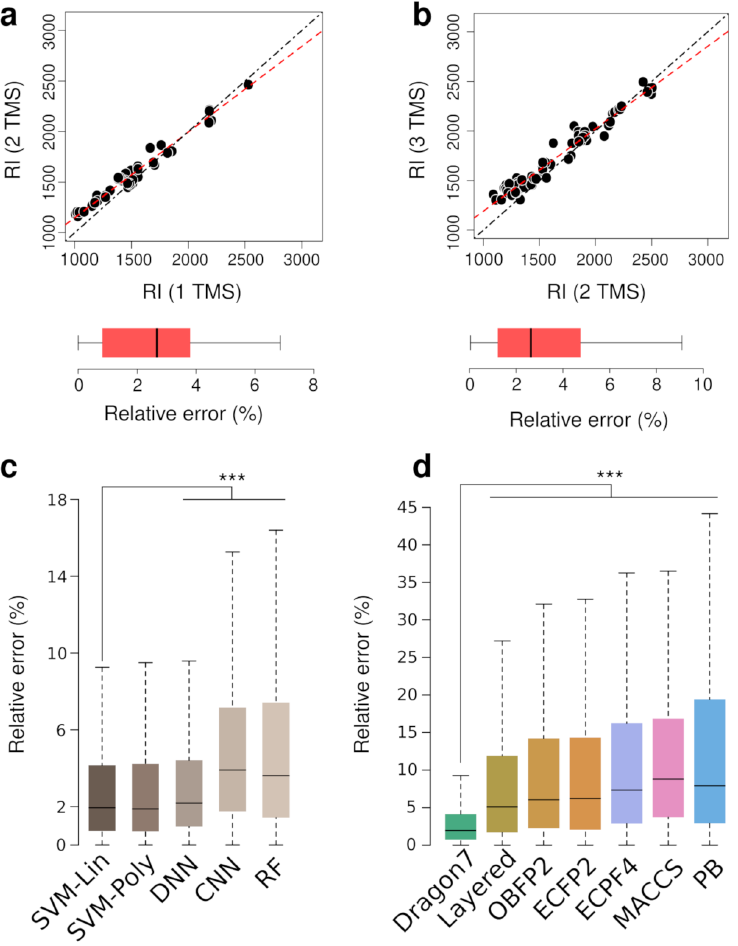
Figure 2. ( a ) RI of derivatized metabolites with 1TMS vs. 2TMS, ( b ) RI of derivatized metabolites with 2TMS vs. 3TMS, and box plots showing the corresponding relative prediction errors as determined by linear regression. Dashed black lines are the identity functions and the dashed red lines are the regression lines. ( c ) Prediction error for each ML model and ( d ) FP class. p -value < 0.001 from a paired Wilcoxon rank tests (n = 5800) is shown as *** . Outliers are not shown (all